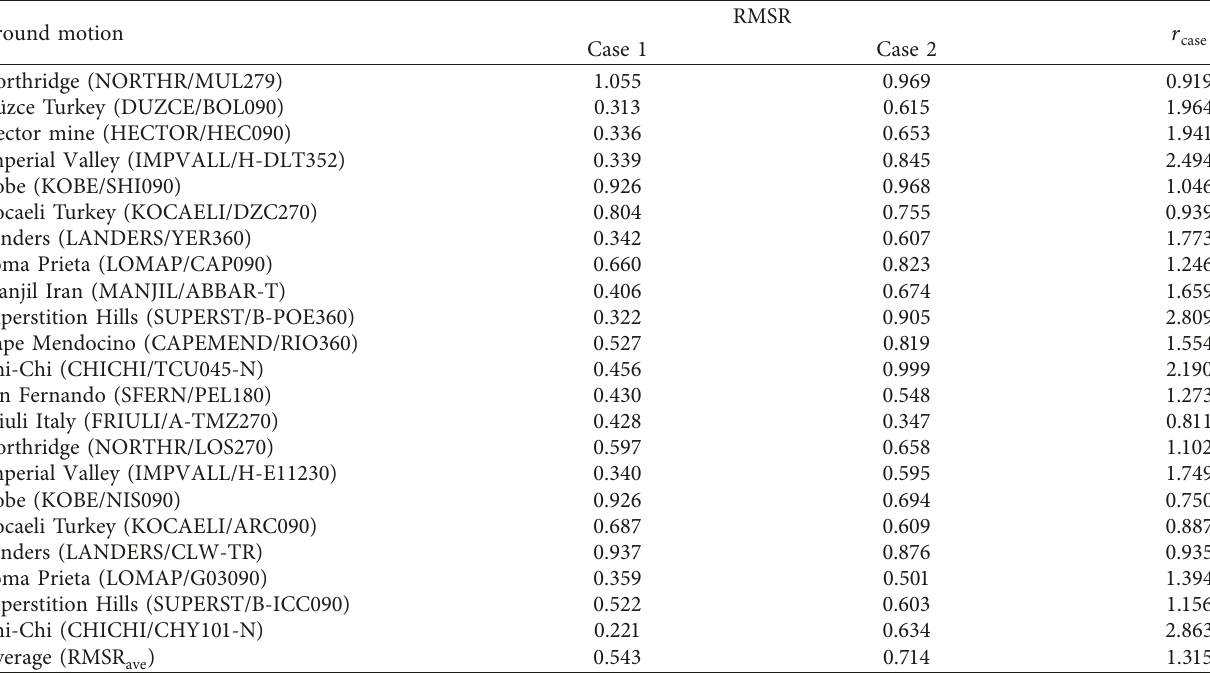
and f . (b) Relationship between RMSR ave